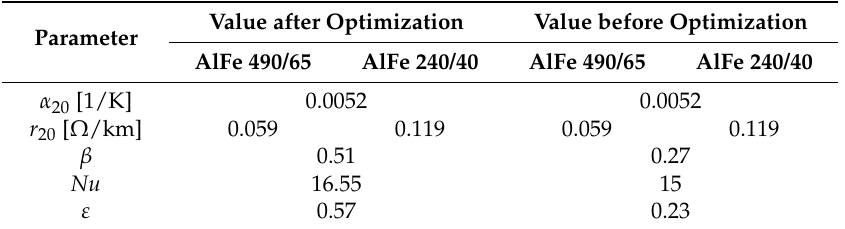
Table 9. Conductor model parameters determined in the proposed optimization procedure. Value after Optimization Value before Optimization Parameter AlFe 490/65 AlFe 240/40 AlFe